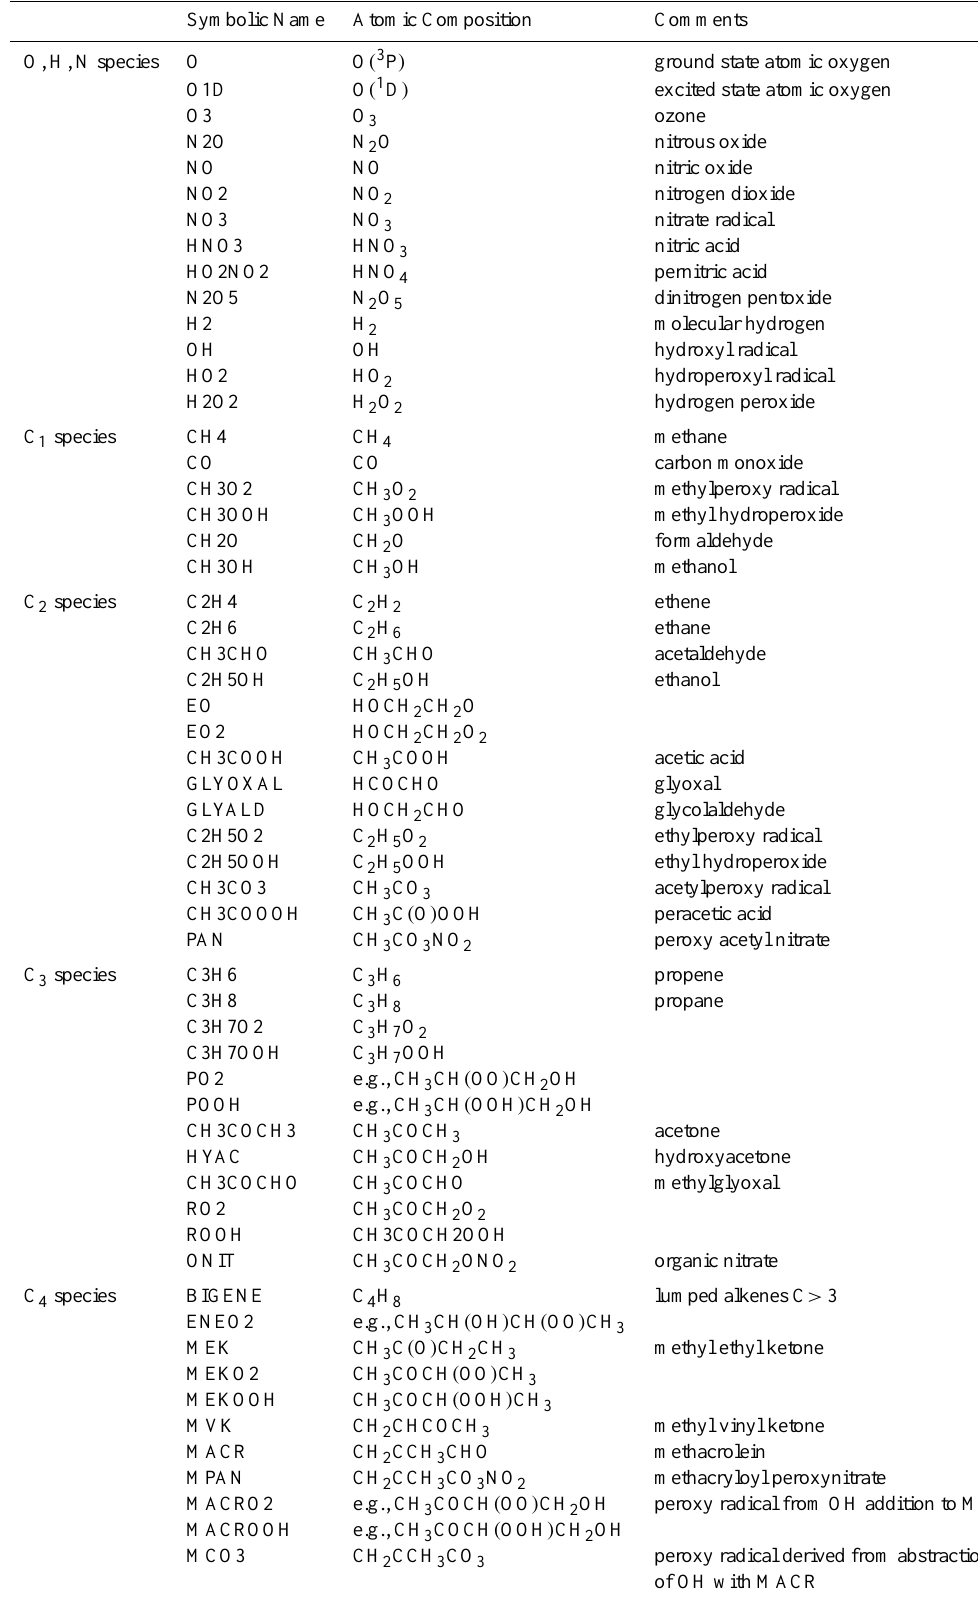
Table 2. Chemical species in